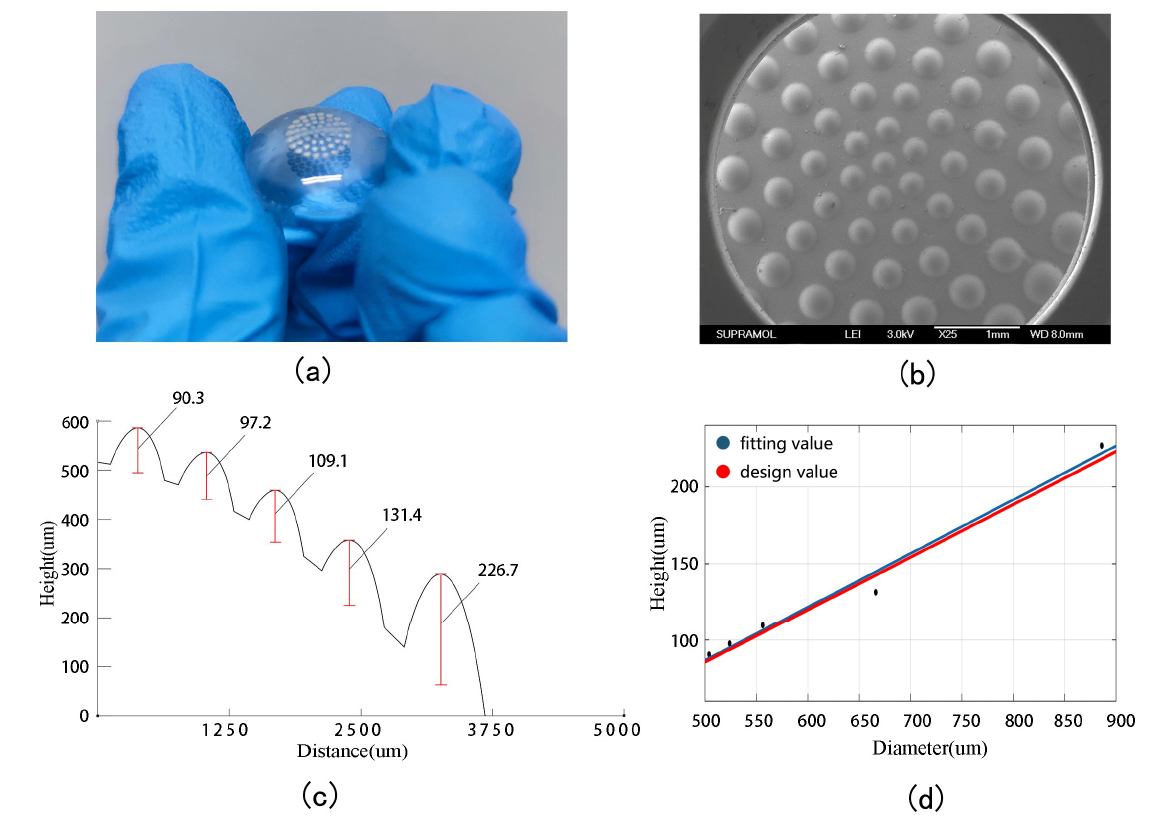
Figure 6. ( a ) A photo of the meniscus multifocusing compound eye lens. ( b ) A photo taken with a scanning electron microscope. ( c ) Profiler measurements of the height of the compound eye. ( d ) Compound eye height fit.